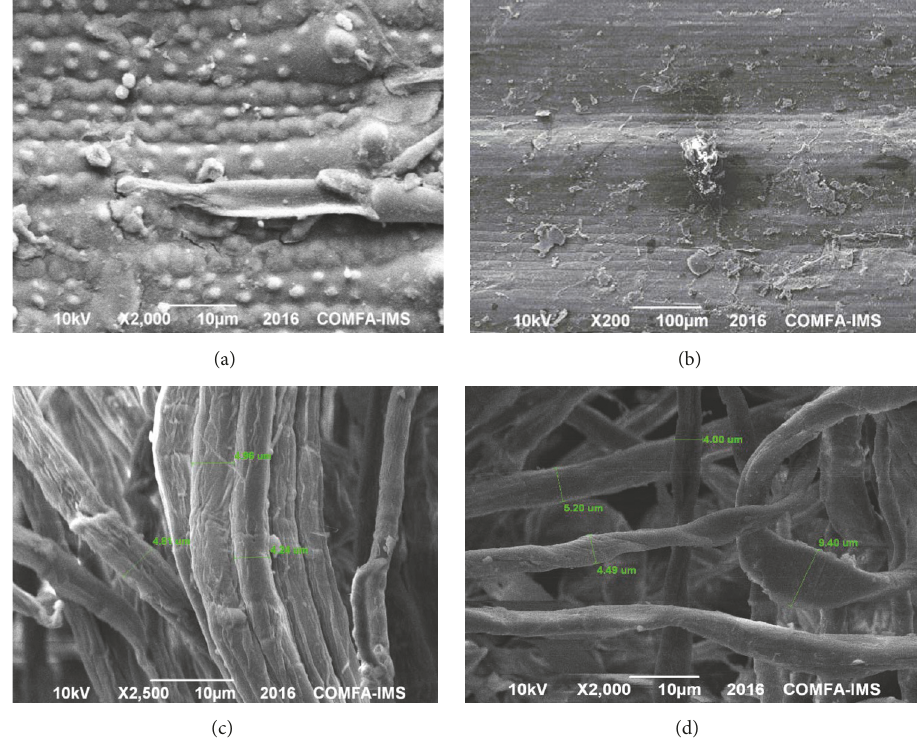
Figure 2: SEM of rice straw: outer layer (a), inner layer (b), cellulose fiber extracted by the ultrasound-assisted alkaline extraction method (c), and cellulose fiber extracted without ultrasound